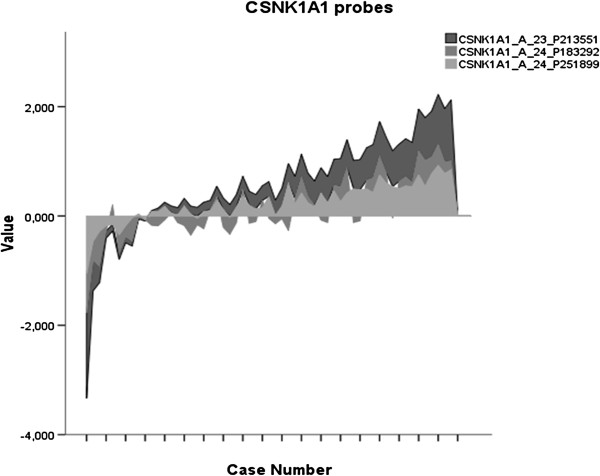
Trends in expression of the three CSNK1A1 probes.